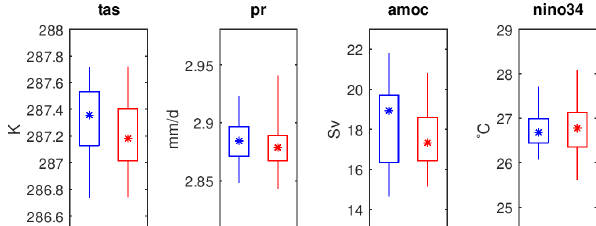
Figure 1. Ensemble spread in the first year after the initialization of the large ensemble (red), compared to the ensemble spread of the regular EC-Earth3 ensemble for the year 1970 of the histori- cal experiment for CMIP6 (blue). The whiskers denote the full en- semble spread (min–max), the boxes the 25th to 75th percentile range, and the stars the median of the distribution. Tas and pr are the annual global mean near-surface temperature and precipitation, respectively. AMOC is the annual average of the monthly maximum Atlantic Meridional Overturning Circulation at 26.5 ◦ N. Nino34 is the annual average sea surface temperature (SST) in the Nino3.4 region (5 ◦ N–5 ◦ S, 170–120 ◦